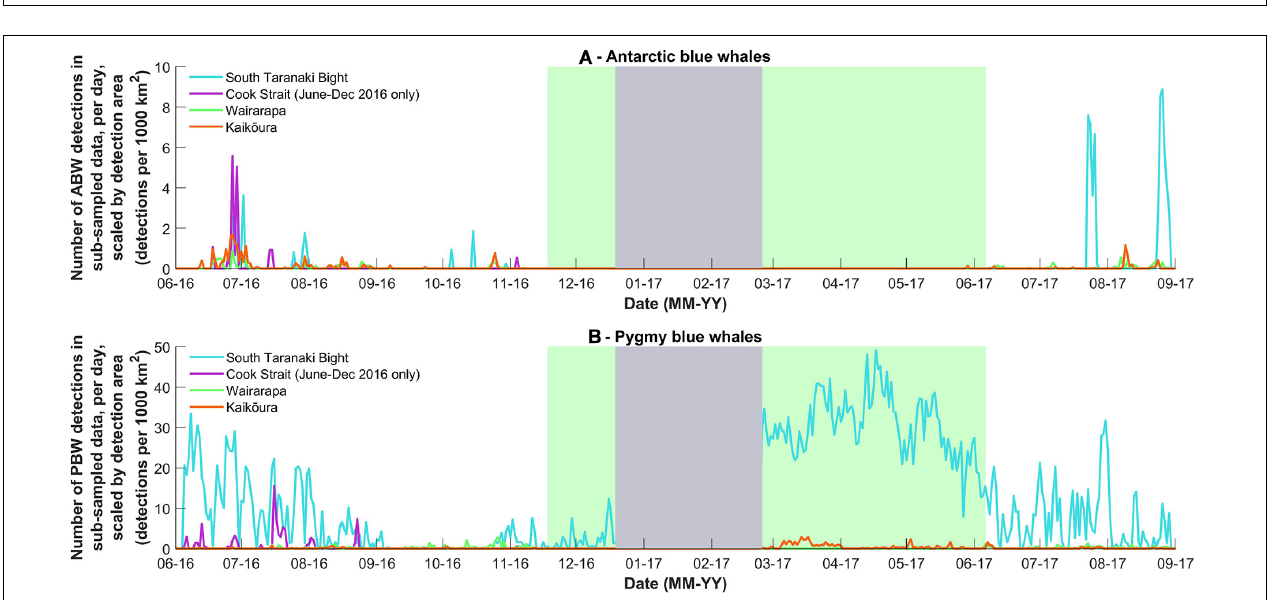
FIGURE 3 | (A) The number of Antarctic blue whale and (B) pygmy blue whale calls detected per day in the stratified random subsample of data from 2016 and 2017. The grey block indicates when the acoustic recorders were not deployed. The green block corresponds to the period in which the Wairarapa data were not analysed due the presence of seismic survey sound in the blue whale call bandwidth. Note Y -axis scale differs between sub-species.